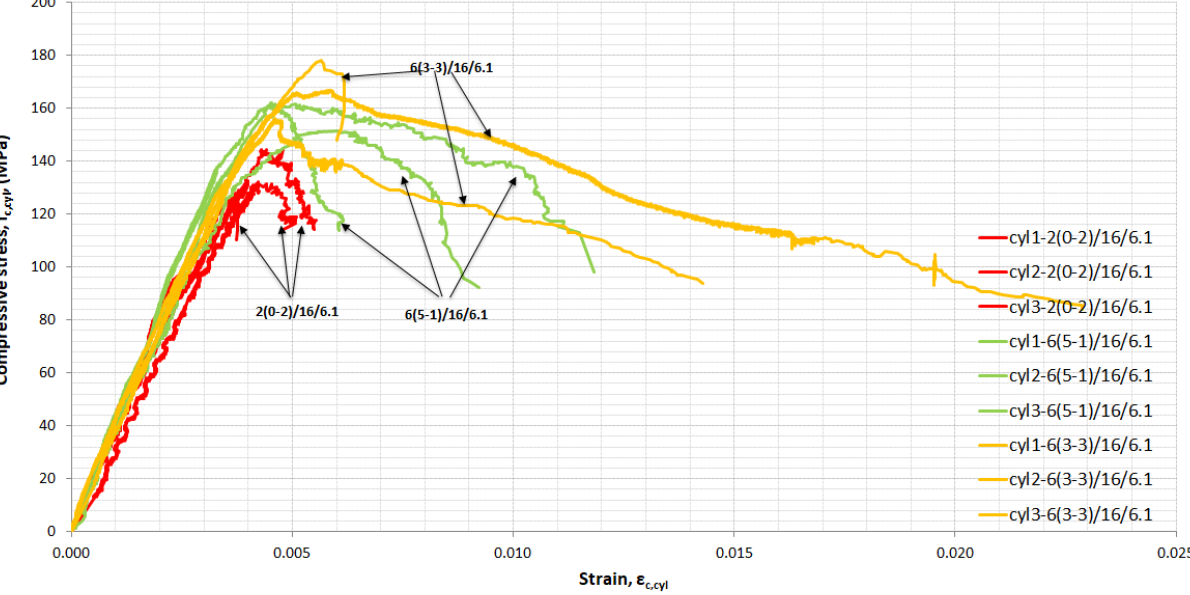
Figure 11. Stress–strain in compression for UHPFRC-influence of fibre content and length.